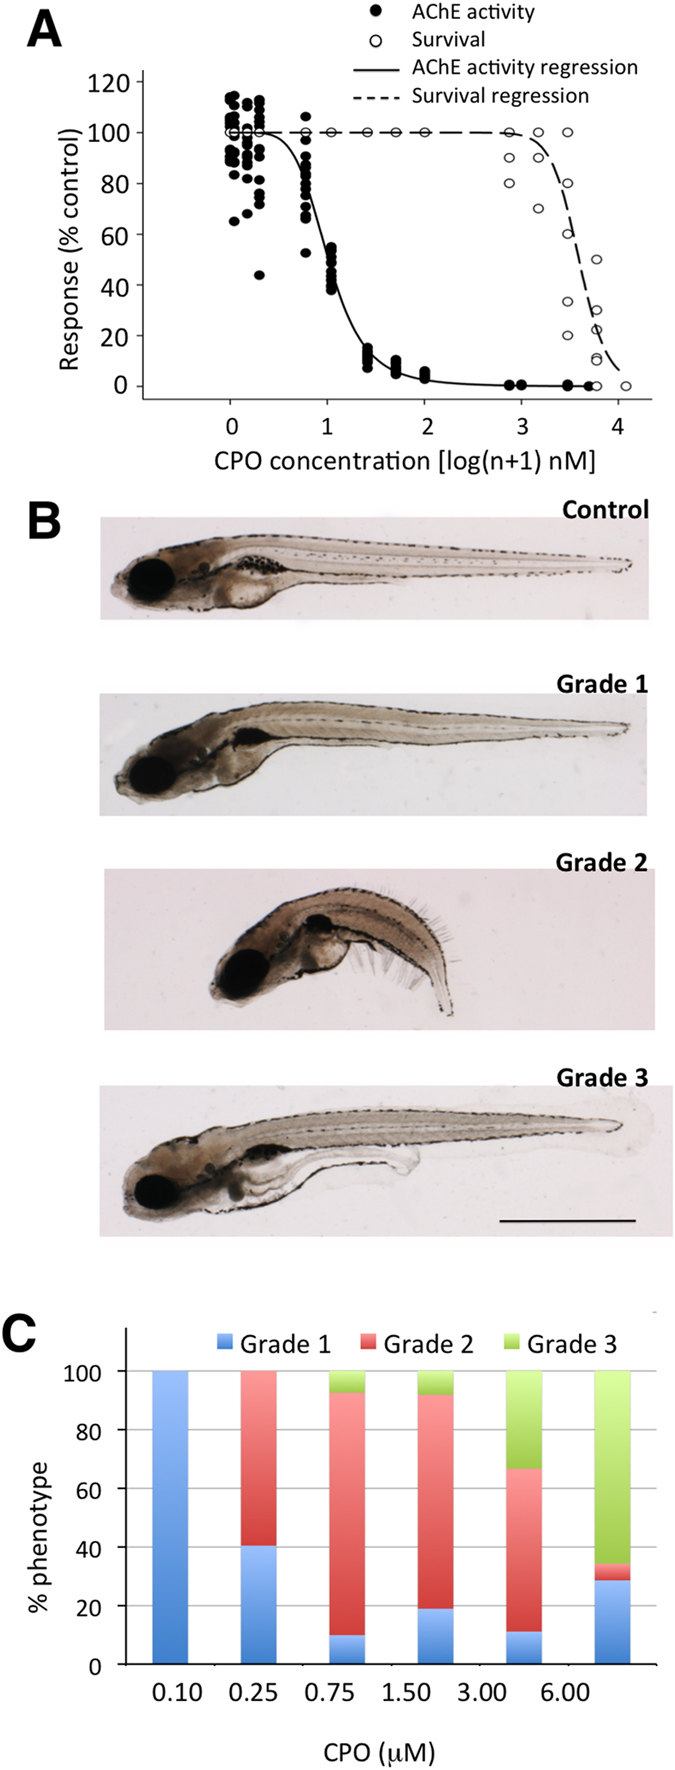
Chlorpyrifos-oxon (CPO) induces concentration-dependent inhibition of acetylcholinesterase (AChE) and the expression of three different phenotypes in zebrafish larvae.(A) Concentration-response analysis of CPO regarding the inhibition of AChE activity and survival in zebrafish larvae exposed to different CPO concentrations from 7 to 8 days post fertilization (24 h exposure, 16 larvae per experimental group, p < 0.0001; AChE activity, F(1,143) = 1950.77, r2 = 0.978; survival, F(1,59) = 251.295, r2 = 0.9208). (B) Lateral views of representative 8 days post fertilization larvae control and the mild (grade 1), moderate (grade 2) and severe (grade 3) phenotypes. (C) Prevalence of the three different phenotypes in response to different CPO concentrations (48 larvae per experimental group). Scale bar: 1 mm.